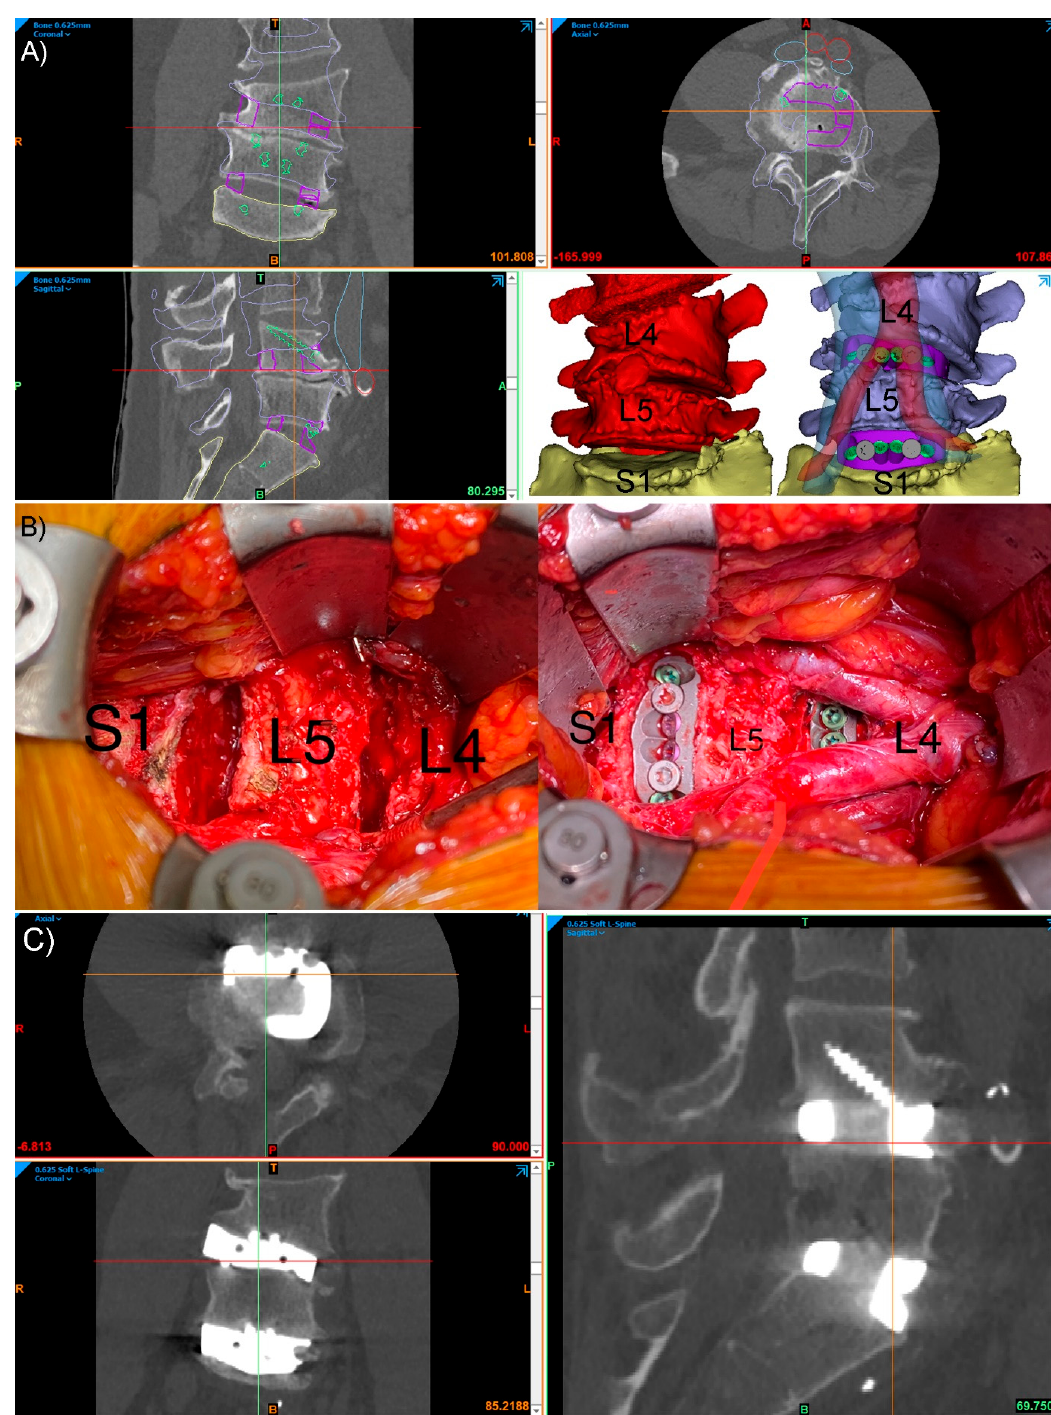
Figure 2. Integral screw fixation, stand-alone Anterior Lumbar Interbody Fusion (ALIF) patient-specific implants (PSIs) L4-5 and L5-S1, in an L4 congenital hemivertebra patient. ( A ) Preoperative CT with planned device (purple outlines), screws (green outlines), vertebral positions (blue outlines) and major vessels (inferior vena cava, blue, and aorta, red). The bottom right panel in ( A ) shows the preoperative pathological anatomy (red) and the planned postoperative state (blue) with translucent aorta (red) and inferior vena cava (blue) shown. ( B ) The intraoperative L4-L5 and L5-S1 discectomies ( left ) and final surgical reconstruction ( right ) with the aortic bifurcation at the L4 level shown. ( C ) Three-month postoperative CT of the construct showing good positioning of the devices, with no evidence of device migration or micromotion, and interbody fusion bone forming through the graft windows of both